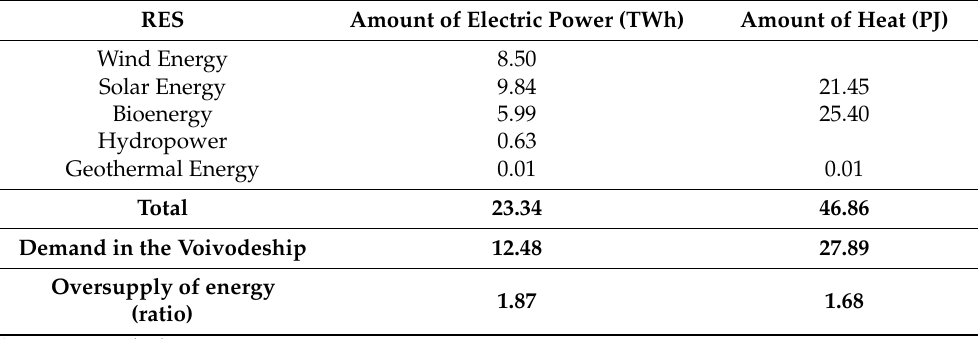
Table 4. Technical potential of RES in the Greater Poland Voivodeship (own calculations).